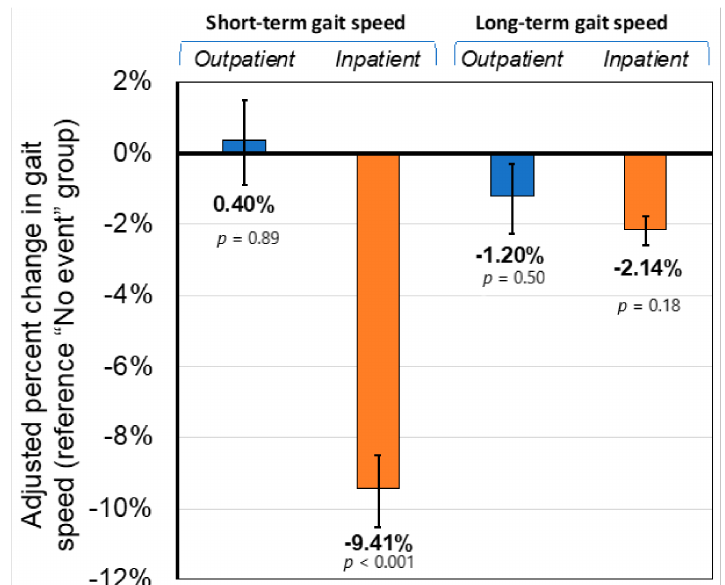
Figure 2. Short- and long-term adjusted percent change in gait speed after an inpatient or outpatient pneumonia event. Labels indicate the point estimate and the p -value for the comparison to the “No event” group.